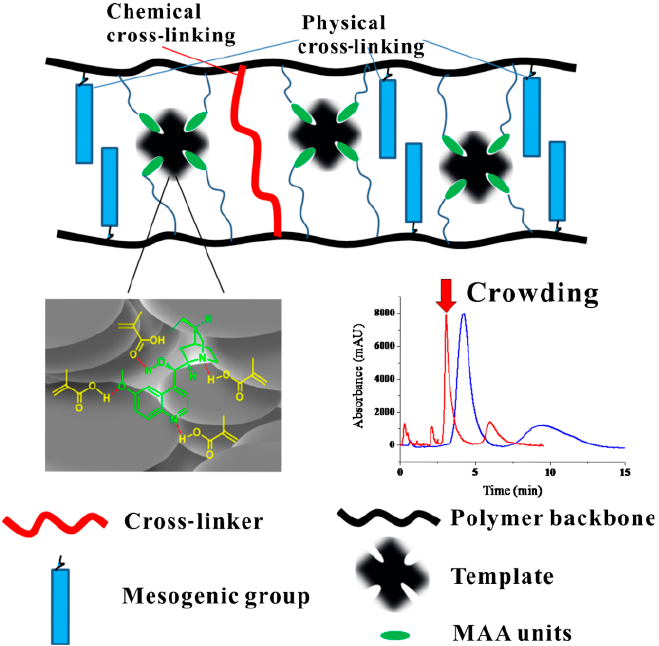
Figure 4. Schematic diagram of LC-MIM preparation process [56].